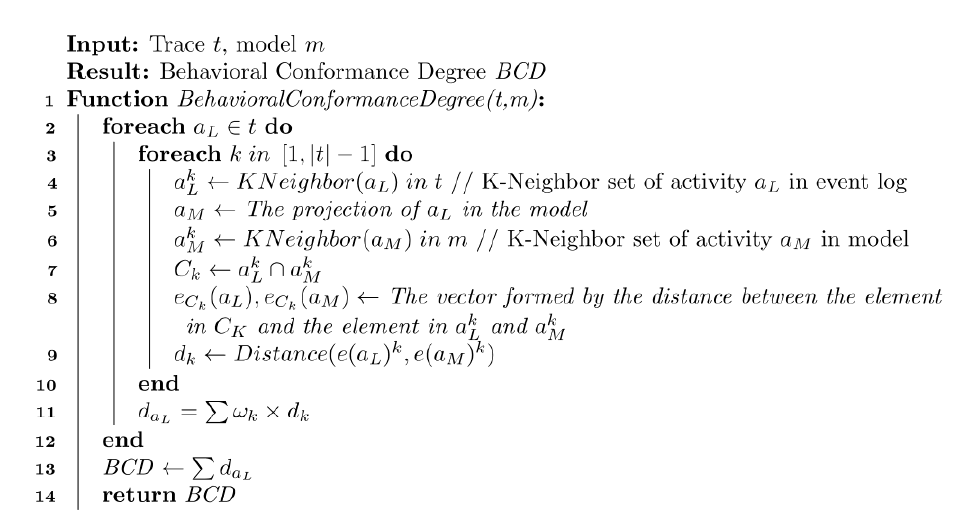
Algorithm 1: Calculation of Behavioral Conformance